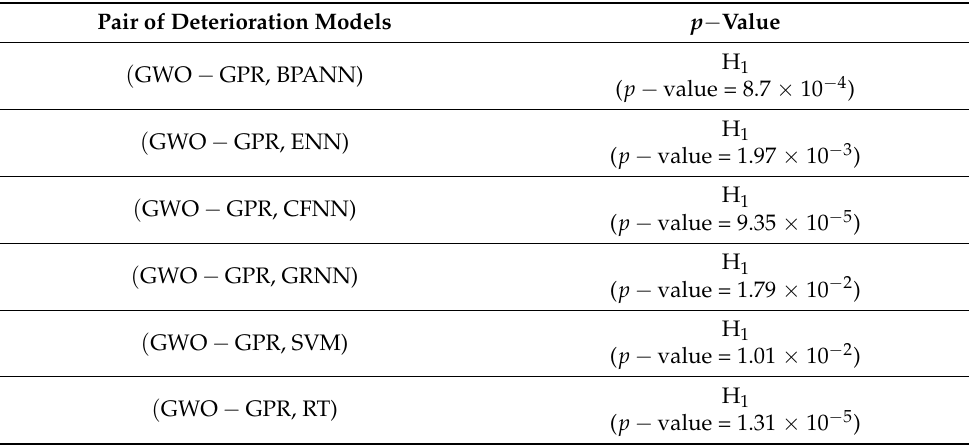
Figure 10. Rankings of deterioration models of concrete ceiling slab. Table 9. Statistical comparison of the developed deterioration model against other models using MAPE based on Student’s t